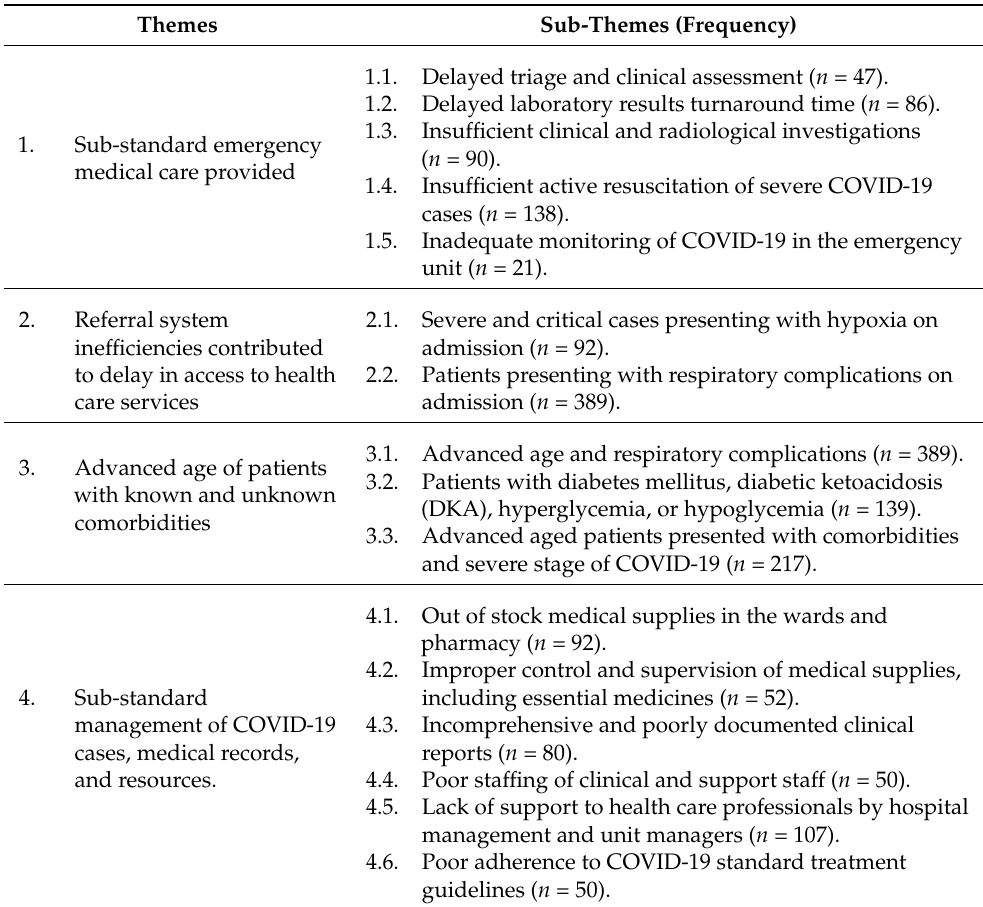
Table 2. Themes and sub-theme on the health system and patient-related factors associated with COVID-19 mortality among hospitalized